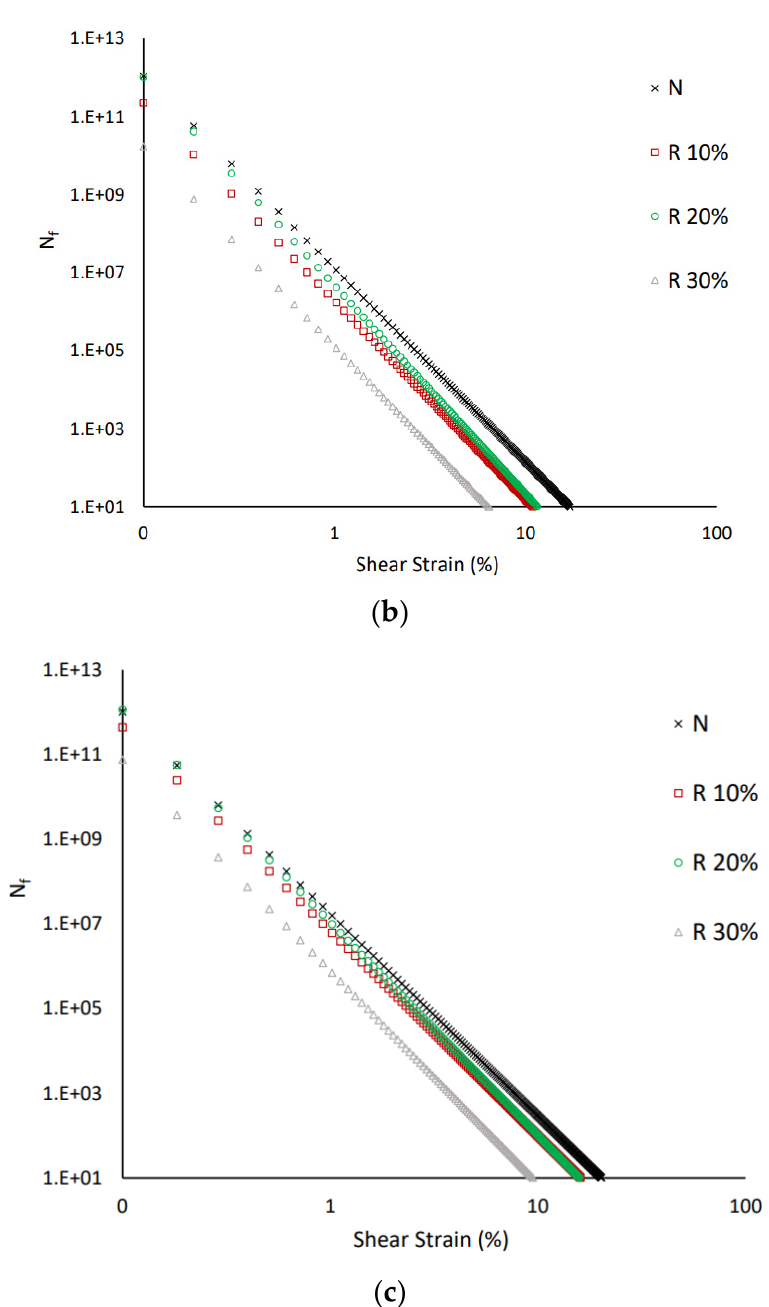
Figure 8. Fatigue life as a function of shear strain at ( a ) 5 °C, ( b ) 15 °C, and ( c ) 25